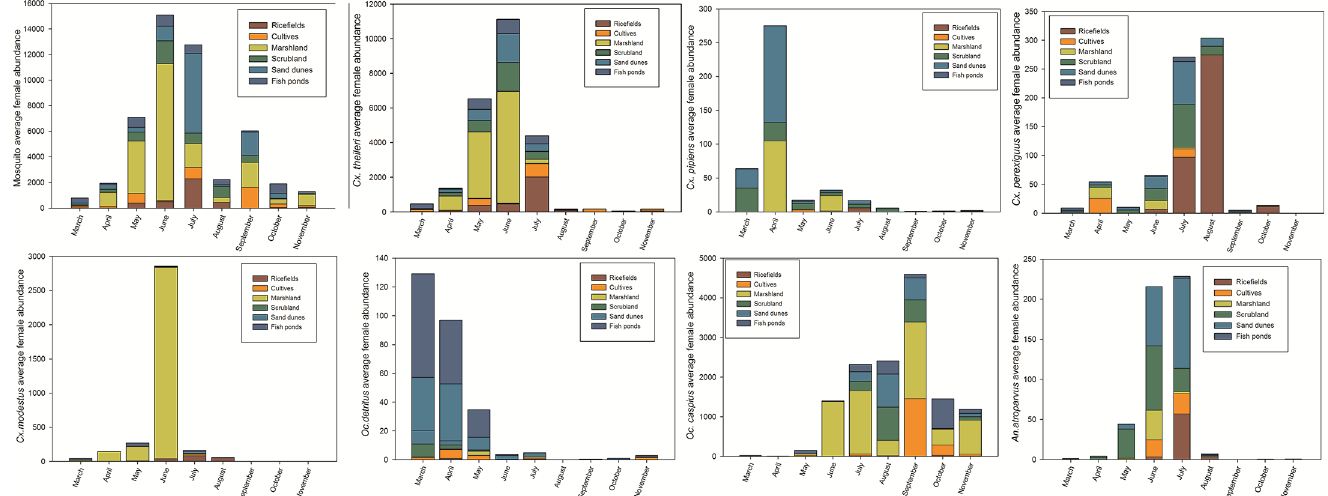
Fig 2. Monthly number of captures of the different mosquito species from March to November 2010 in the different ecological units studied. Cx . theileri was more abundant in marshland, but also in other landscape units. Cx . perexiguus was more abundant in ricefields, scrubland and other landscapes. Cx . modestus was more abundant in marshland and in June. Cx . pipiens was abundant in marshland, sand dunes and scrubland, Oc . caspius was abundant in all landscapes, while Oc . detritus was significantly more abundant in halophytic marshes of sand dunes and fish ponds.